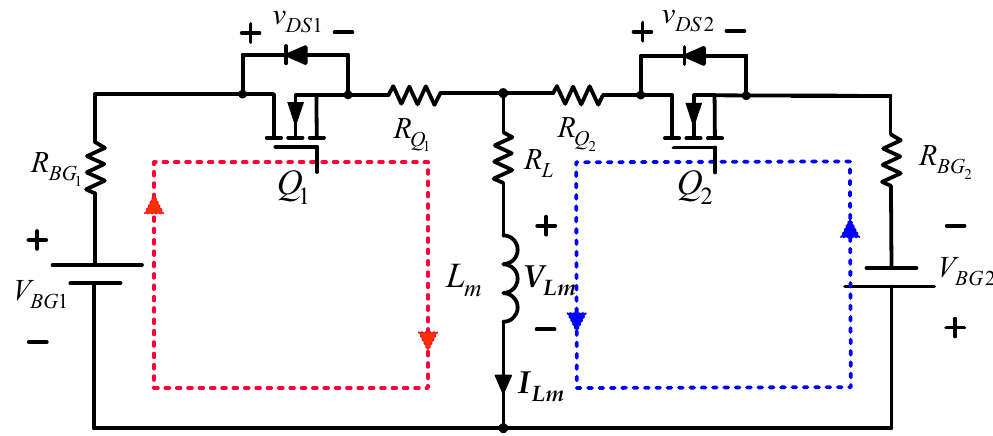
Figure 7. Equivalent circuit of a PCL with nonideal component parameters.